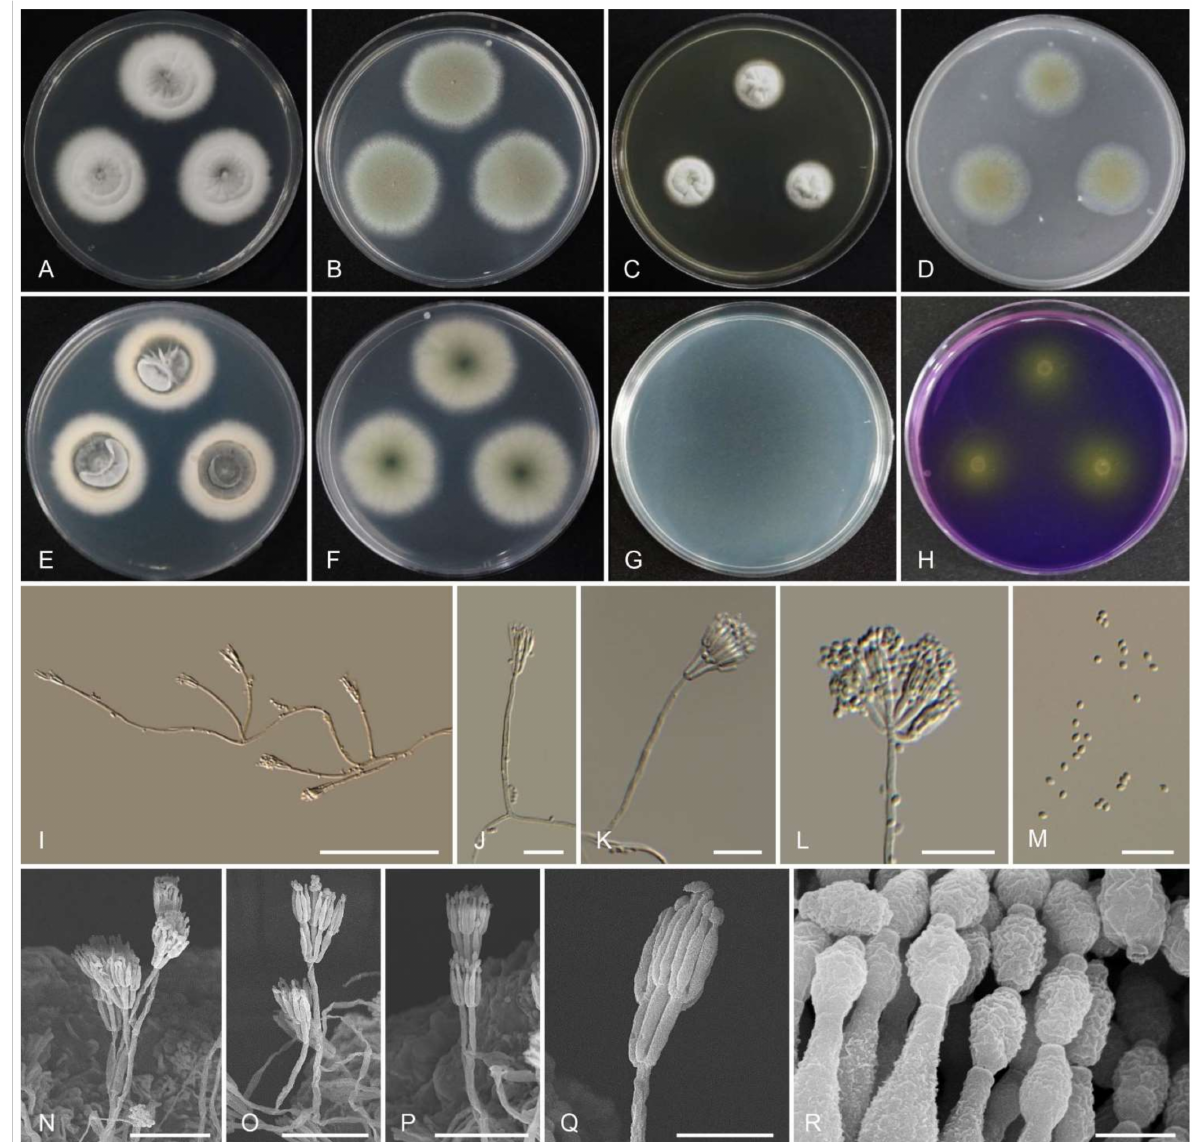
Figure 5. Morphology of Talaromyces koreana CNUFC YJW2-13. ( A , E ) Colonies on Czapek yeast autolysate agar (CYA). ( B , F ) Malt extract agar (MEA). ( C ) Yeast extract sucrose agar (YES). ( D ) Oatmeal agar (OA). ( G ) Dichloran 18% glycerol agar (DG18). ( H ) Creatine sucrose agar (CREA). (( A – D , G , H ) Obverse view and ( E , F ) reverse view). ( I – L , N – Q ) Conidiophores. ( M , R ) Conidia. (( I – M ) LM and ( N – R ) SEM). Scale bars: ( I ) = 100 µ m, ( J – L ) = 20 µ m, ( M , Q ) = 10 µ m, ( N – P ) = 25 µ m, and ( R ) = 2 µ m. Table 3. Morphological characteristics of Talaromyces koreana CNUFC YJW2-13 compared with those of the reference strains Talaromyces boninensis and Talaromyces reverso-olivaceus .